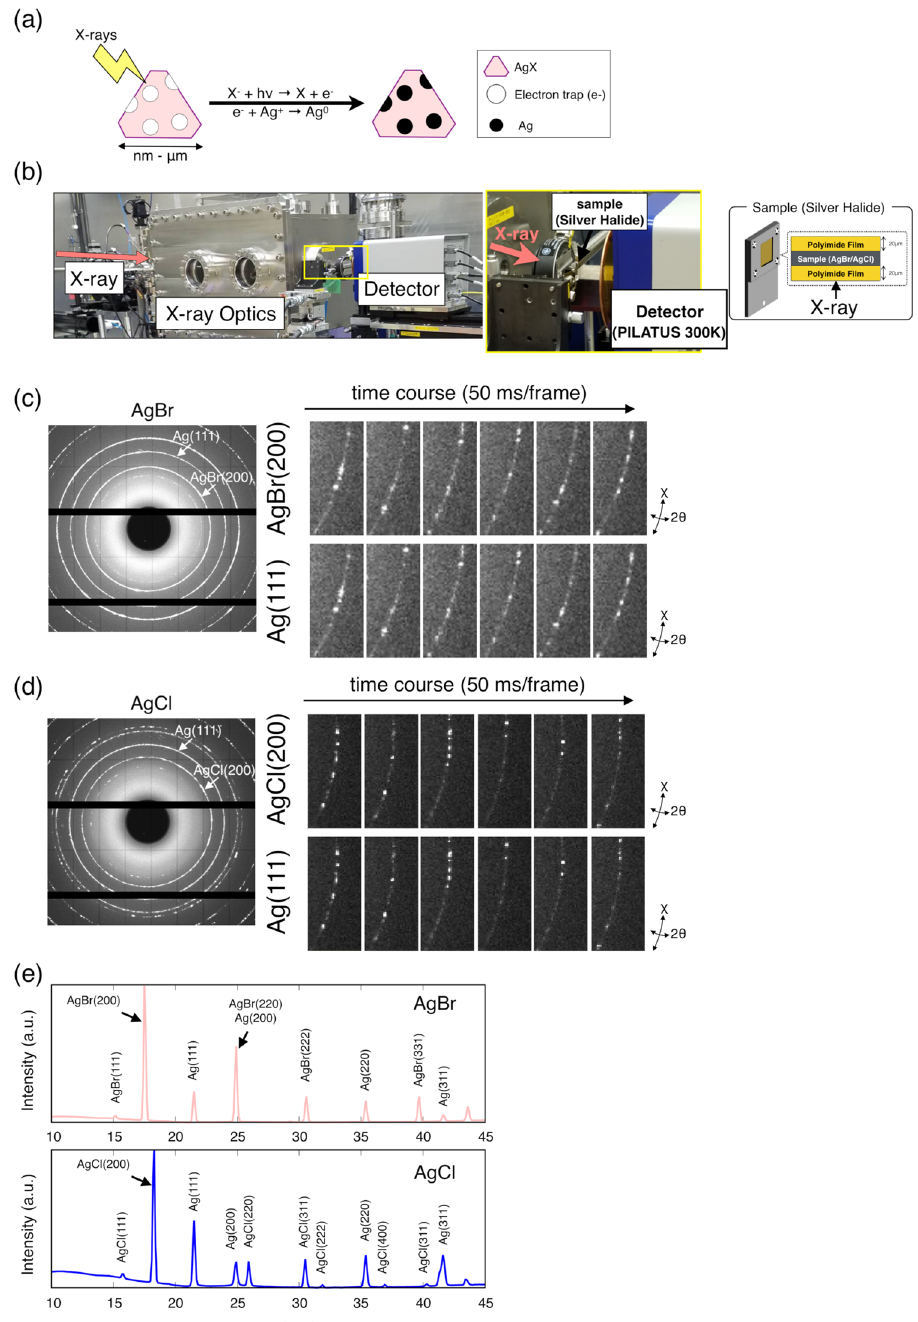
Figure 2. DXB measurement for silver halides. ( a ) Schematic illustration of the photoinduced chemical reaction with silver halide. ( b ) DXB setup at the BL39XU in SPring-8 (Japan). Monochromatic X-rays (E = 15.2 keV) were focused by two K–B mirrors. The beam size was 0.52 × 0.77 μm. The sample-to-detector distance was 85 mm, and 2000 time-resolved diffraction images from silver halide nanocrystals immobilized on the polyimide film were recorded with a 2D photon-counting detector (Pilatus 300 K, Dectris Switzerland). ( c , d ) X-ray diffraction images of silver halides from the DXB measurement with monochromatic X-rays. The exposure time per frame and interval time were set to 50.0 and 53.0 ms, respectively. ( e ) Two-theta diagrams in AgBr, AgCl and Ag. Diffraction peaks are assigned to each plane of the face-centred cubic (fcc) lattice structure in AgBr, AgCl, and